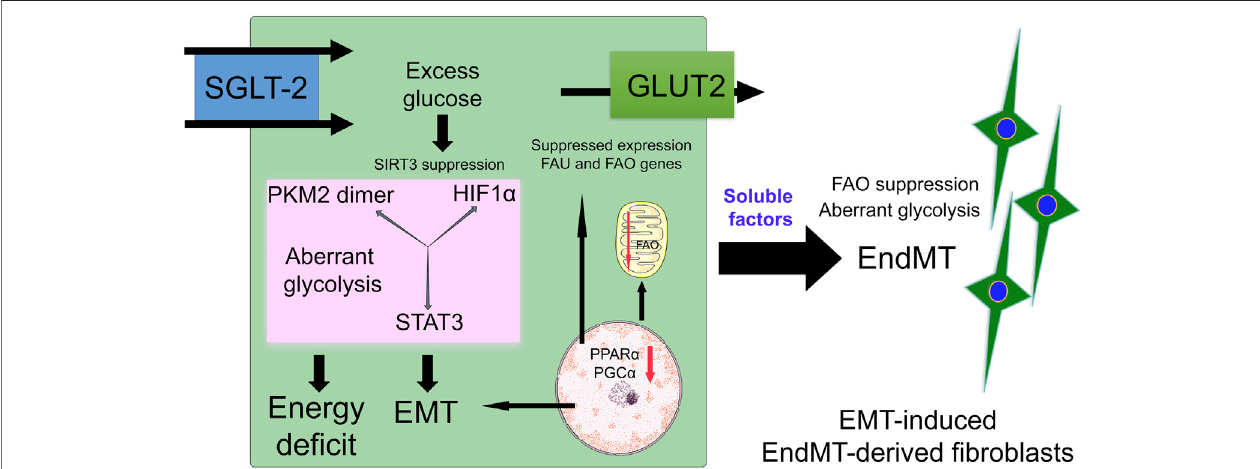
FIGURE4| Defectivecentralmetabolismindiabetictubularepithelialcells.DiabetictubularepithelialcellshavehigherexpressionofSGLT-2whichtransportsurine glucoseintotubularcells.ExcessglucoseaccumulatesinthecytosolwhichresultsinactivationofSIRT3de fi ciency-linkeddisruptionincentralmetabolism.Thisdefective centralmetabolism ischaracterized byPKM2-and STAT3-linked aberrant glycolysisand suppression offatty acidoxidation. Defective central metabolismcontributes to EMT events. These EMT events produce and release soluble factors which affect the homeostasis of endothelial cells and induce EndMT events in the kidneys.